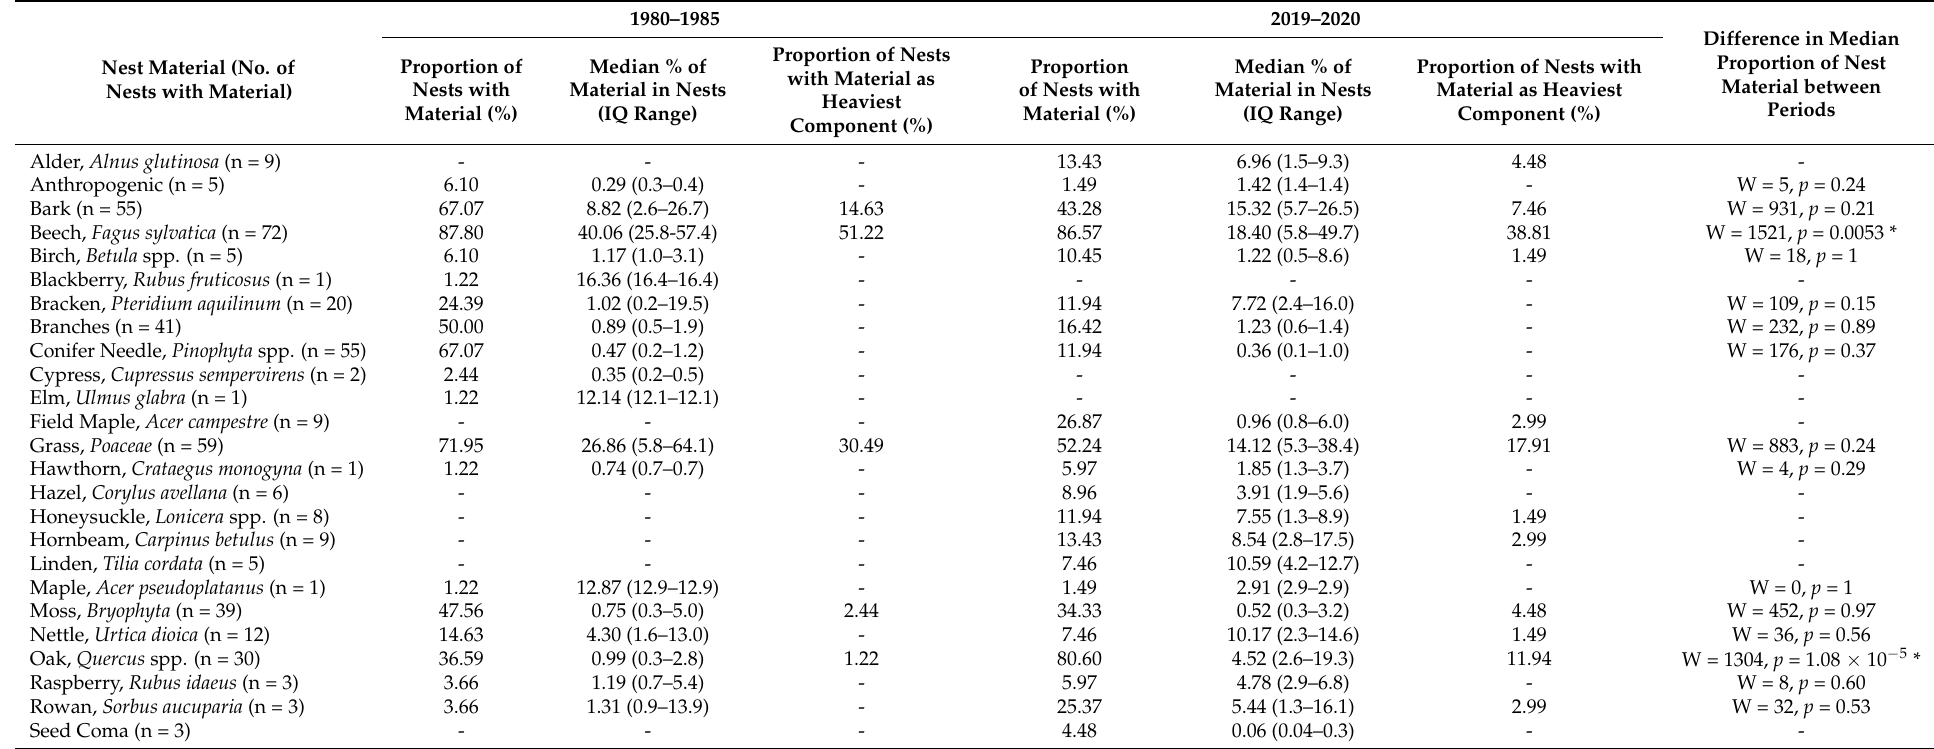
Table 1. Nest materials found in hazel dormouse summer nests from the period 1980 to 1985 and 2019 to 2020. IQ = interquartile range. The difference in median proportion of nest material between periods was tested using Mann–Whitney. Asterisk (*) indicate significant values.